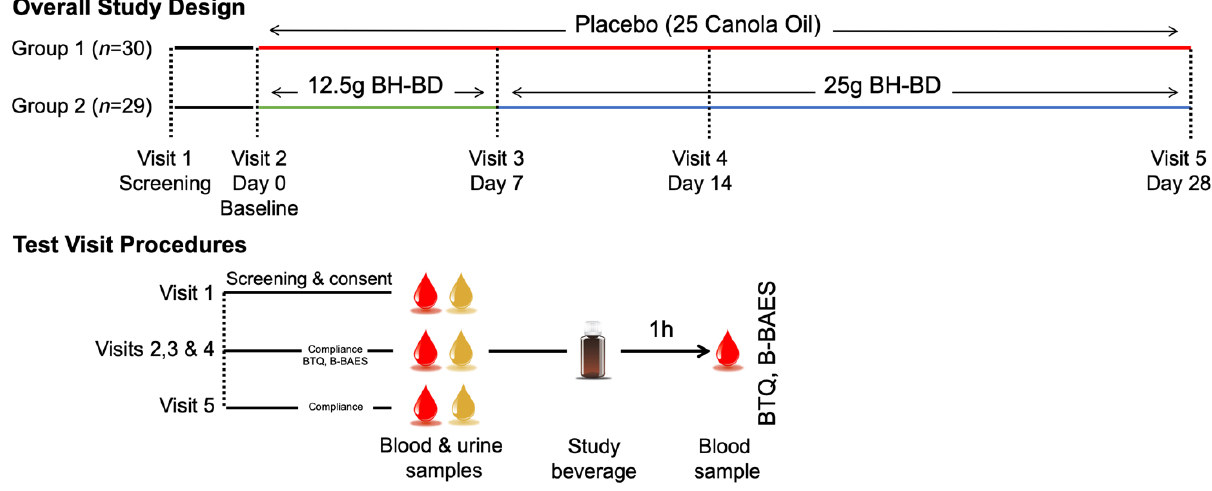
Figure 2. Study design schematic. Abbreviations B-BAES, Brief Biphasic Alcohol Effect Scale; BH-BD, bis-hexanoyl (R)-1,3-butanediol; BTQ, beverage tolerability questionnaire.